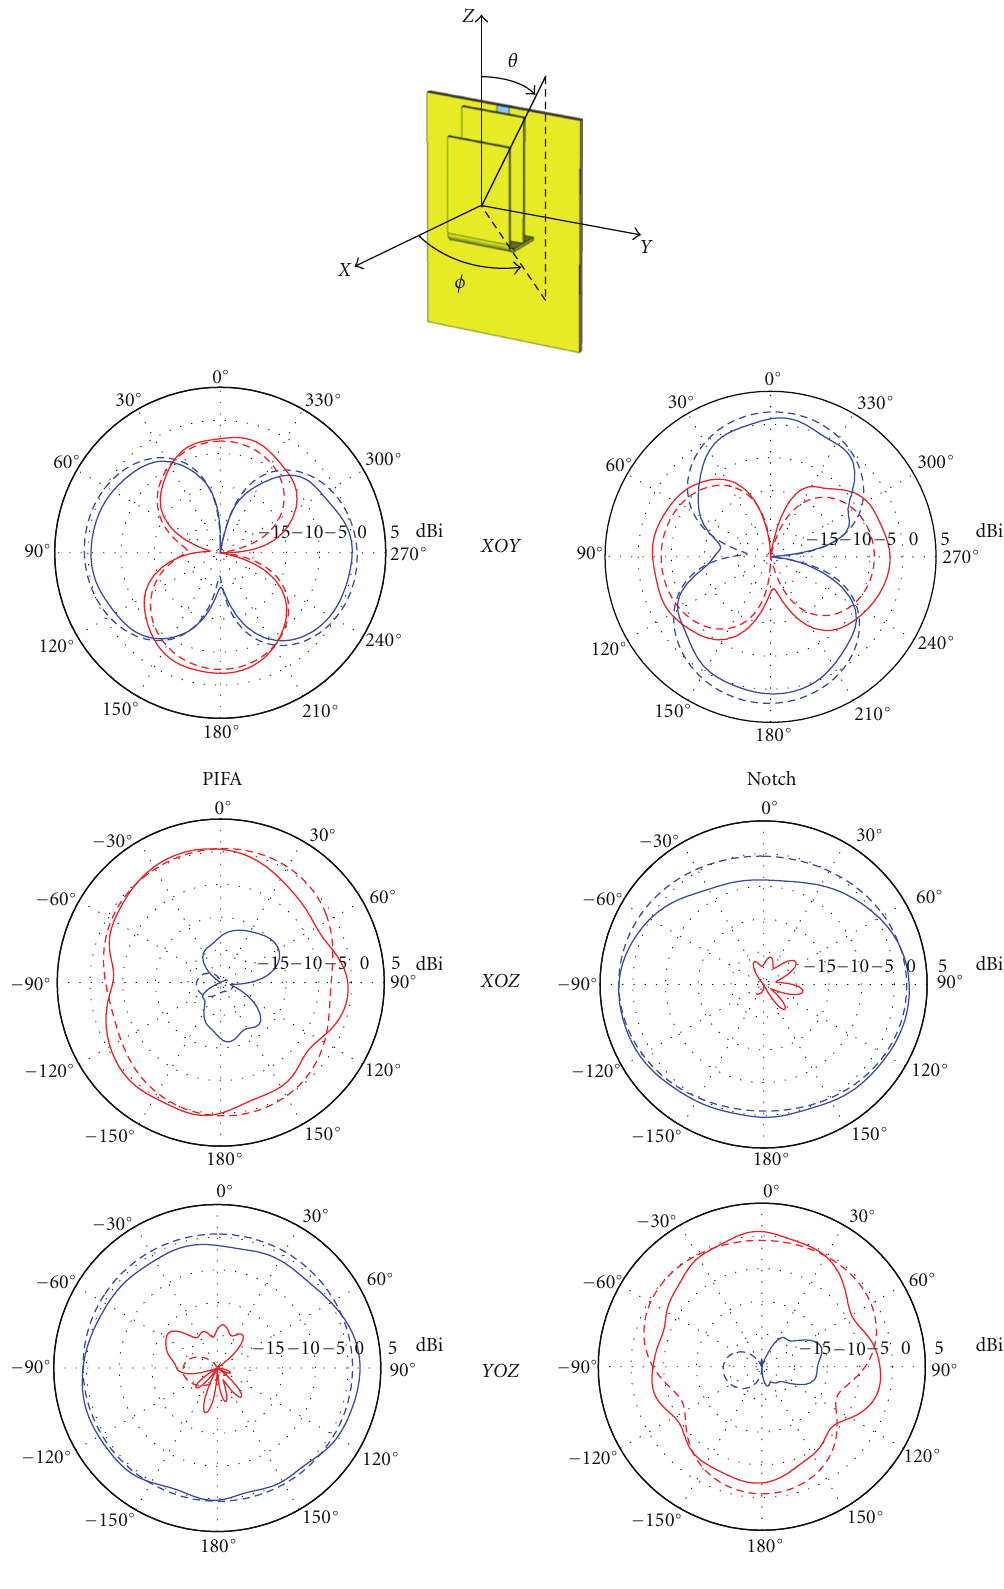
Figure 7: Gain patterns of compact multiantenna prototype at 3.6 GHz. Solid line is measurement, dashed is simulation. Vertical polarization is red line, horizontal is blue